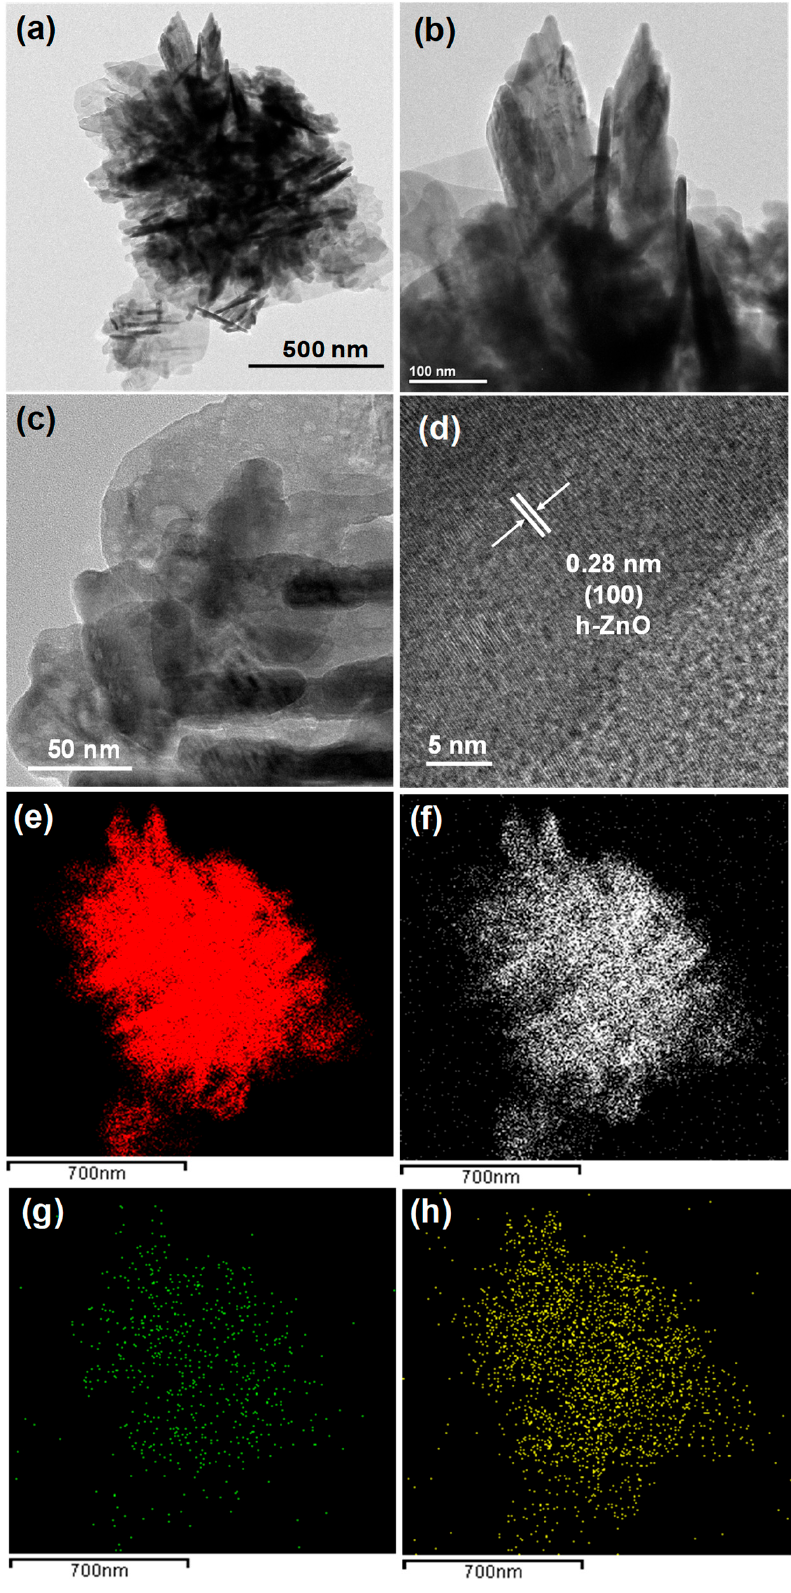
Figure 2 . Transmission electron microscopy (TEM) images ( a – c ), ( d ) corresponding high-resolution TEM image, and elemental mapping of ( e ) Zn, ( f ) O, ( g ) Mo, and ( h ) S for the MZ nanocomposite.